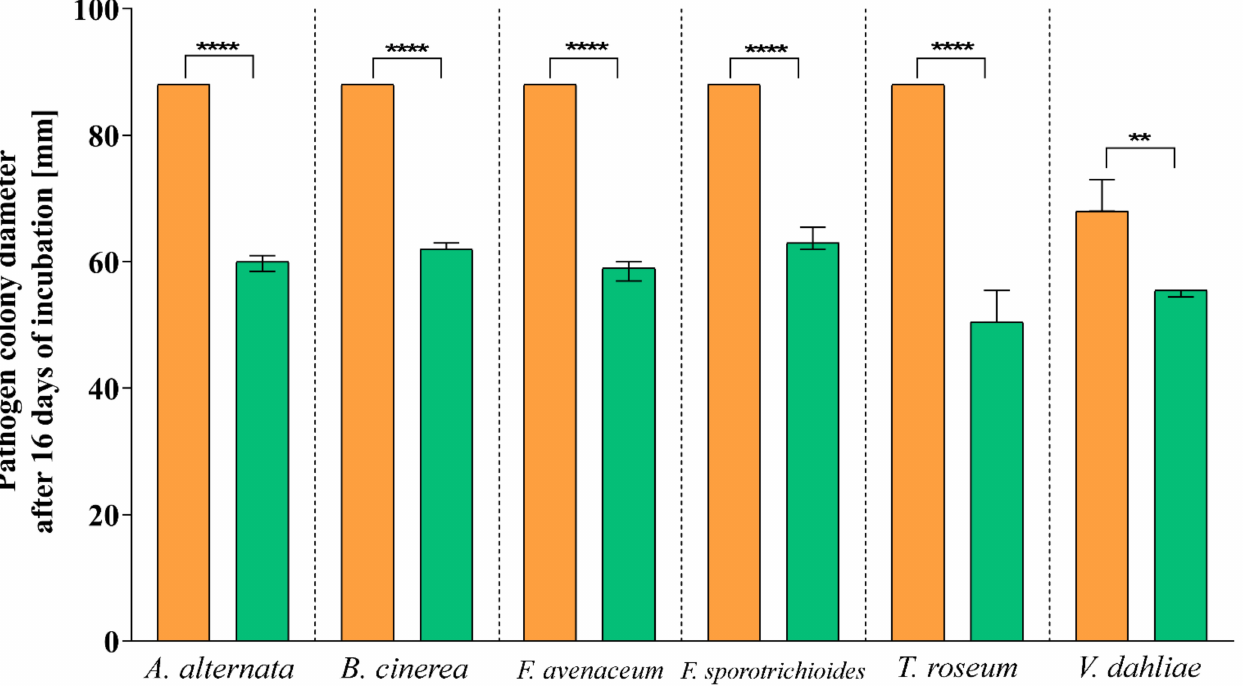
Figure 2. Diameter of the colonies of the tested pathogens after 16 days of co-growth with the endophyte. The graph presents pathogen colony diameter after 16 days of incubation in positive control (orange) and in antagonistic test plate (green). The statistical analysis was prepared with T-Student Test, α = 0.05. Statistically significant differences are marked as: **** p < 0.0001, ** p < 0.01.